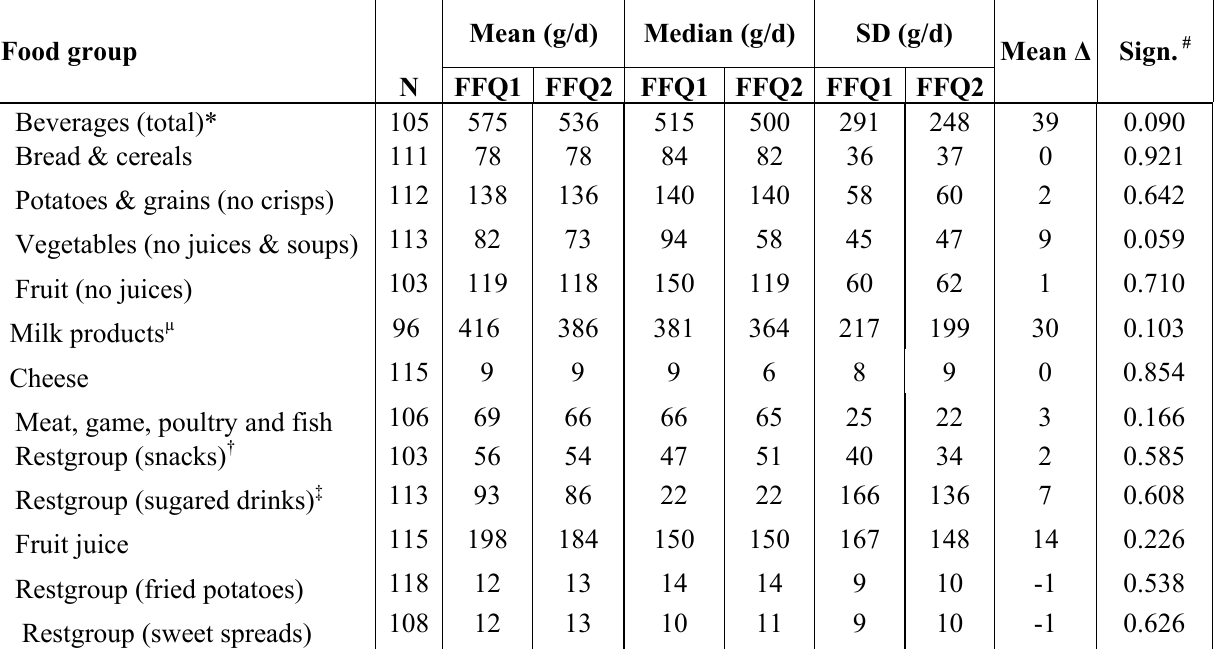
Table 2. Comparison of mean and median food (group) intakes estimated from the first and the second FFQ in the reproducibility